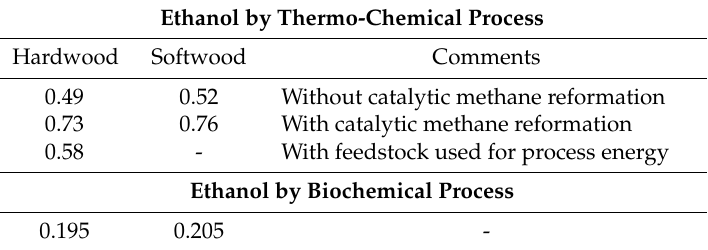
Table 2. Mass ratio of ethanol from hardwood and softwood through different conversion processes (Based on study of